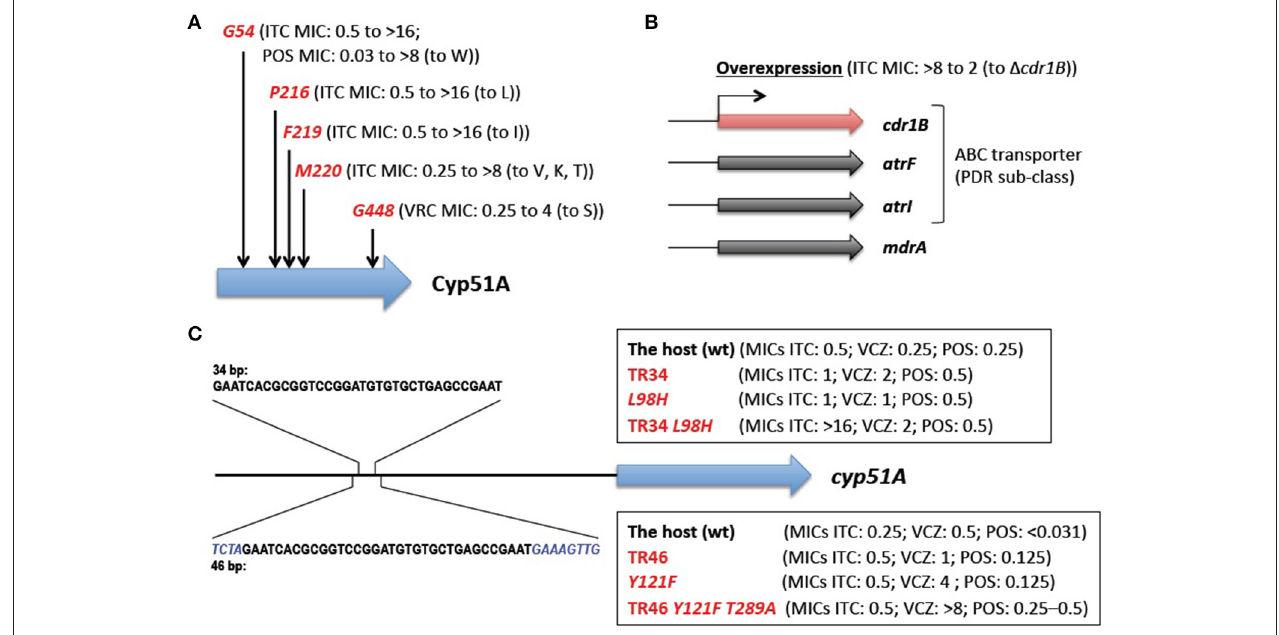
FIGURE 2 | Known azole resistance mechanisms in A. fumigatus. (A) Amino acid substitutions responsible for azole resistance. G54, P216, F219, M220, and G448 show the position at which amino acid changes resulted in azole resistance. The MICs of the strains harboring the change (to the indicated amino acid) are shown in parentheses ( Mann et al., 2003; Mellado et al., 2004; Camps S. M. et al., 2012; Krishnan-Natesan et al., 2012). (B) The efflux transporters related to azole resistance. The MIC of the strain with overexpression of the cdr1B gene is shown in parentheses ( Fraczek et al., 2013). (C) The tandem repeat sequences in a cyp51A promoter. The none-overlapping bases are shown in italics. The MICs of the strains harboring TR34 or TR46 and/or amino acid change(s) are shown in parentheses ( Snelders et al., 2011, 2015). ITCZ, itraconazole; PSCZ, posaconazole; VRCZ,